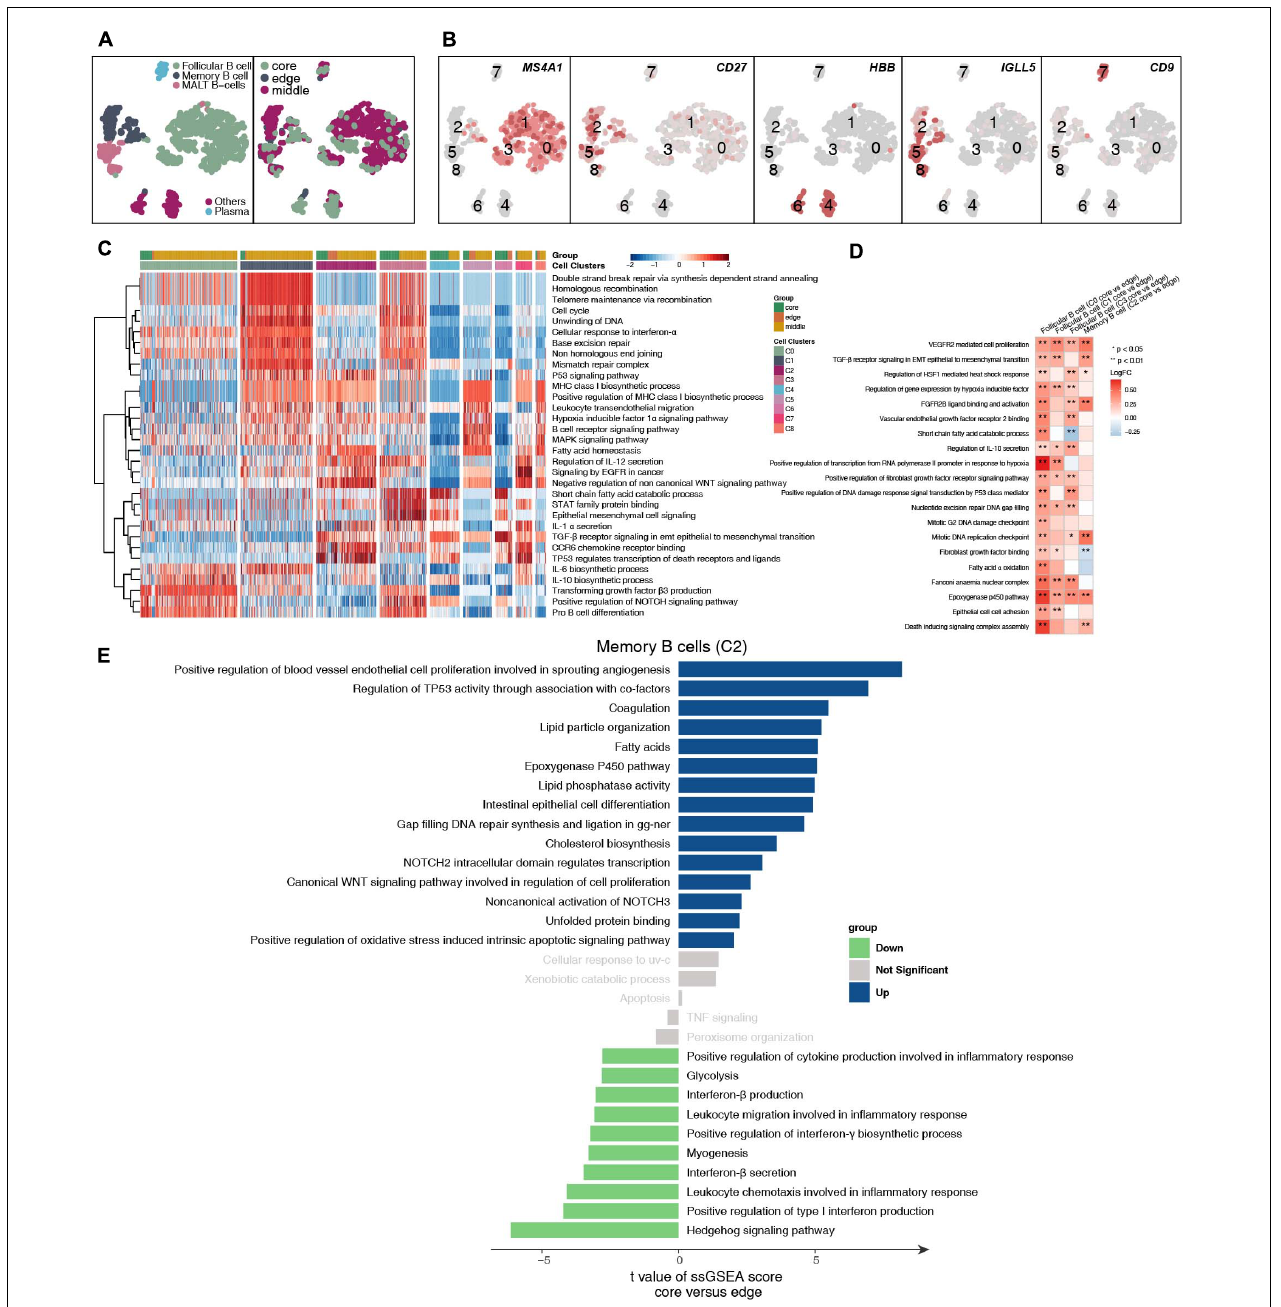
FIGURE 5 | B cell clusters in LUAD. (A) tSNE plot of 1,136 B cells, which are color-coded by their associated cluster or the sample location. (B) tSNE plot, which is color-coded for expression of marker genes for the cell types, as indicated. (C) Heatmap of the ssGSEA score, as estimated using gene sets from MsiDB, for eight B cell clusters: follicular B cells (cluster 0), follicular B cells (cluster 1), memory B cells (cluster 2), follicular B cells (cluster 3), other B cells (cluster 4), MALT B cells (cluster 5), other B cells (cluster 6), plasma B cells (cluster 7), and MALT B cells (cluster 8). (D) Heatmap depicting the mean differences in pathway activities scored per cell by GSVA between the tumor core and tumor edge across the follicular B cells (cluster 0), follicular B cells (cluster 1), memory B cells (cluster 2), follicular B cells (cluster 3), other B cells (cluster 4), MALT B cells (cluster 5), other B cells (cluster 6), plasma B cells (cluster 7), MALT B cells (cluster 8). The x -axis of the heatmap indicates different B cell clusters, and the y -axis indicates pathway activities scored per cell by GSVA. Each square represents the fold change or difference in each indicated pathway activity scored per cell by GSVA between the tumor core and tumor edge across the follicular B cells (cluster 0), follicular B cells (cluster 1), memory B cells (cluster 2), follicular B cells (cluster 3), other B cells (cluster 4), MALT B cells (cluster 5), other B cells (cluster 6), plasma B cells (cluster 7), and MALT B cells (cluster 8). Red indicates upregulation, while blue indicates downregulation. (E) Differences in pathway activities scored per cell by GSVA between tumor core and tumor edge in the follicular B cells (cluster 0), follicular B cells (cluster 1), memory B cells (cluster 2), follicular B cells (cluster 3), other B cells (cluster 4), MALT B cells (cluster 5), other B cells (cluster 6), plasma B cells (cluster 7), and MALT B cells (cluster 8). T -values are from a linear model. * P < 0.05; ** P < 0.01.